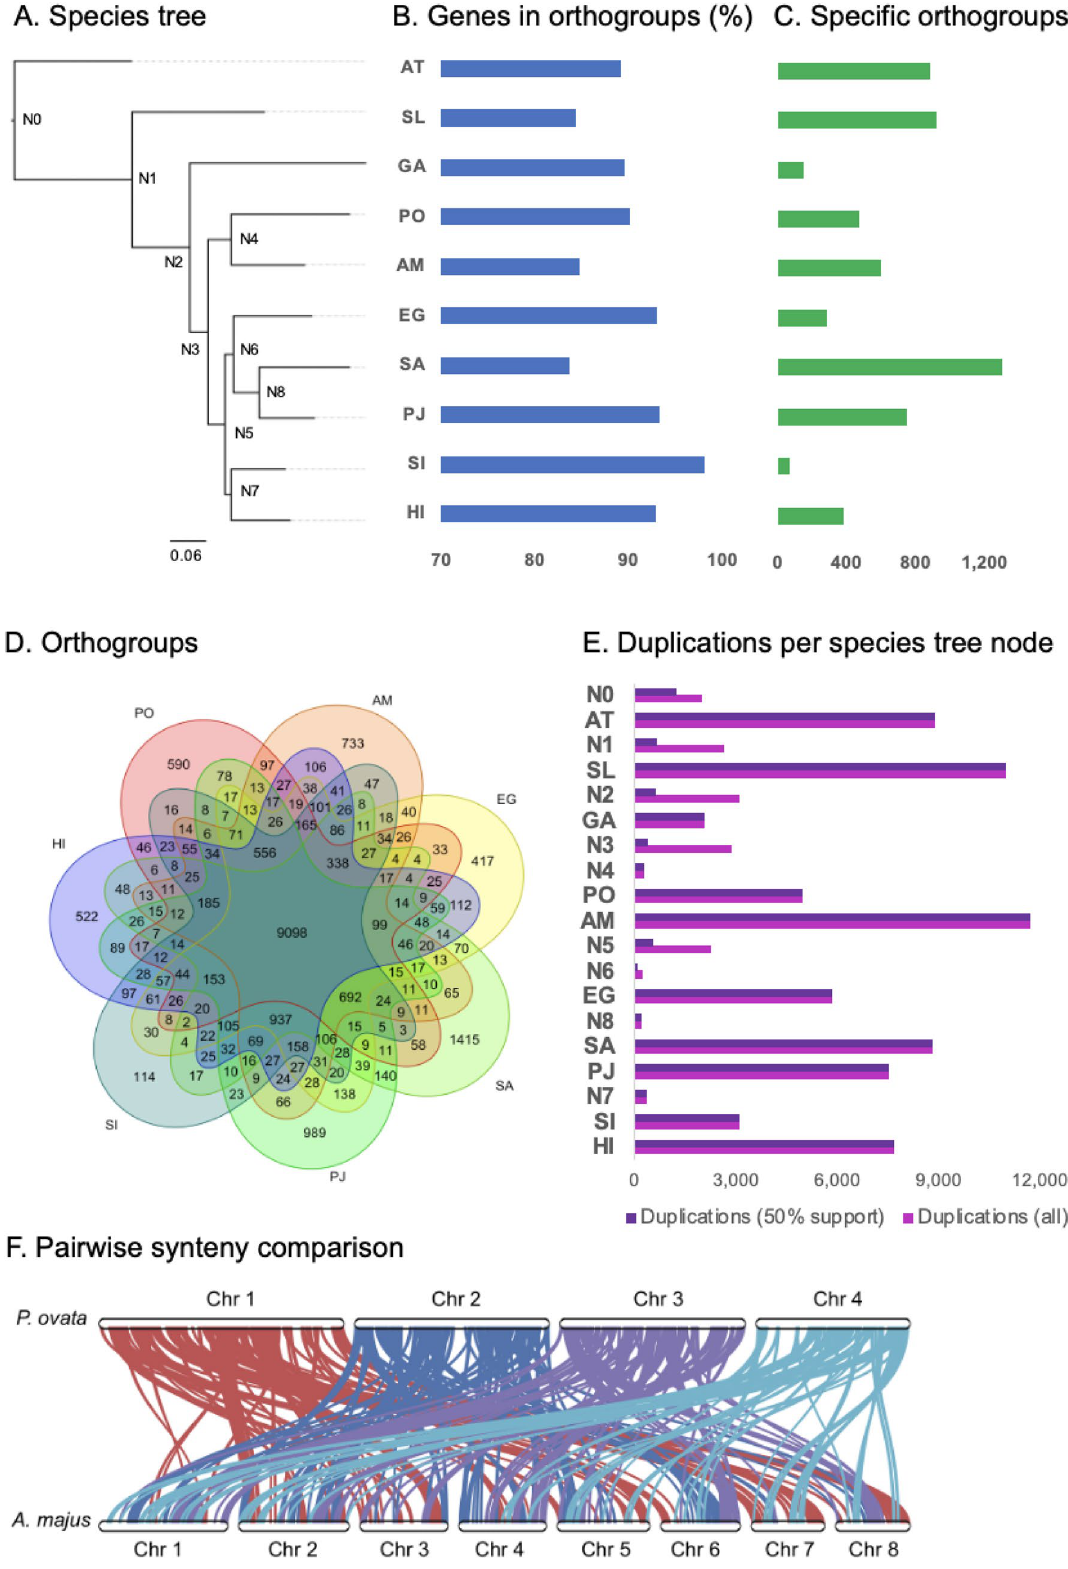
Figure 3. Comparative genomic analyses between P. ovata (PO) with other Laminales species (GA, Genlisea aurea ; AM, Antirrhinum majus ; EG, Erythranthe guttata ; SA, Striga asiatica ; PJ, Phtheirospermum japonicum ; HI, Handroanthus impetiginosus ; SI, Sesamum indicum ), one Brassicales (AT, Arabidopsis thaliana ) and one Solanales (SL, Solanum lycopersicum ). ( A ) Bar charts for each species in B & C were aligned to the corresponding species in the species tree. Bootstrap values of the species tree of each node are one except N3 is 0.76. ( B ) Percentage of genes from each species assigned to orthogroups. ( C ) The number of species-specific orthogroups. ( D ) Venn diagrams of orthogroups from 7 species (GA, PO, AM, EG, SI, and AT). ( E ) The number of gene duplication events per internal and terminal nodes from the species-based-phylogenetic tree. ( F ) Pairwise synteny comparison between P. ovata and A. majus